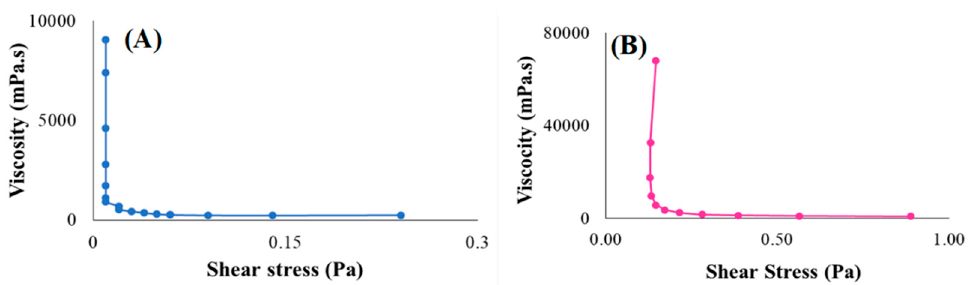
Figure 6. Rheological behaviour presented as viscosity versus shear stress for ( A ) placebo and ( B ) drug-loaded formulation.